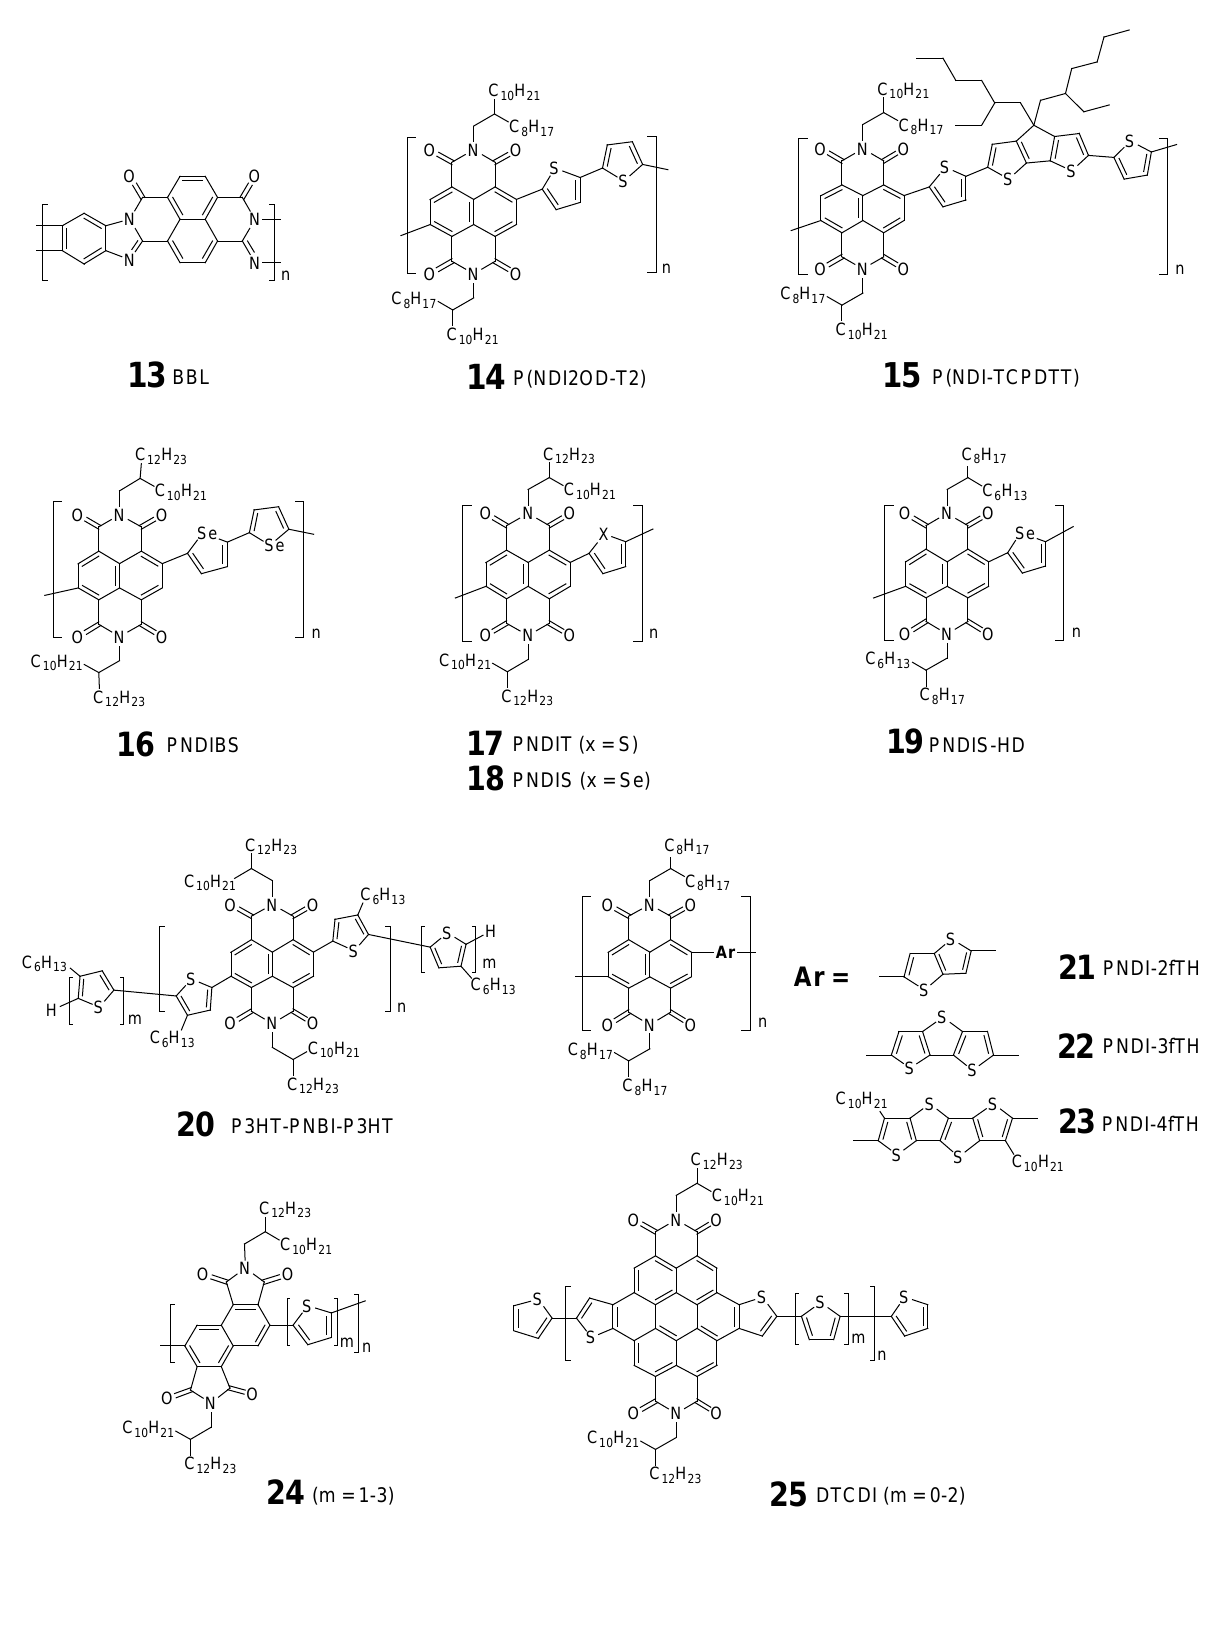
Figure 4. Molecular structures of naphthalene diimide (NDI)-based polymer acceptors ( 13 – 25